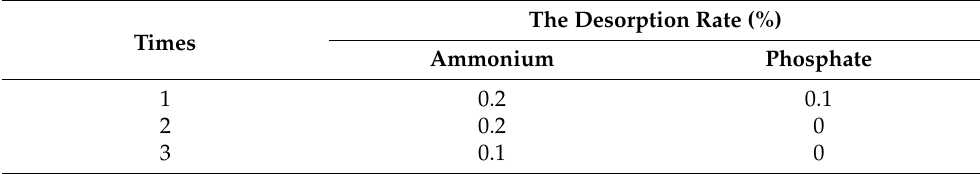
Table 6. Desorption in water of SOD saturated with adsorbed nitrogen and phosphorus.